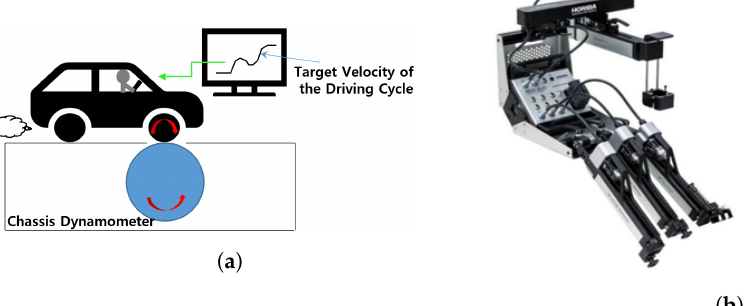
Figure 1. ( a ) Fuel Economy and Exhaust Test with Chassis Dynamometer. ( b ) HORIBA ADS